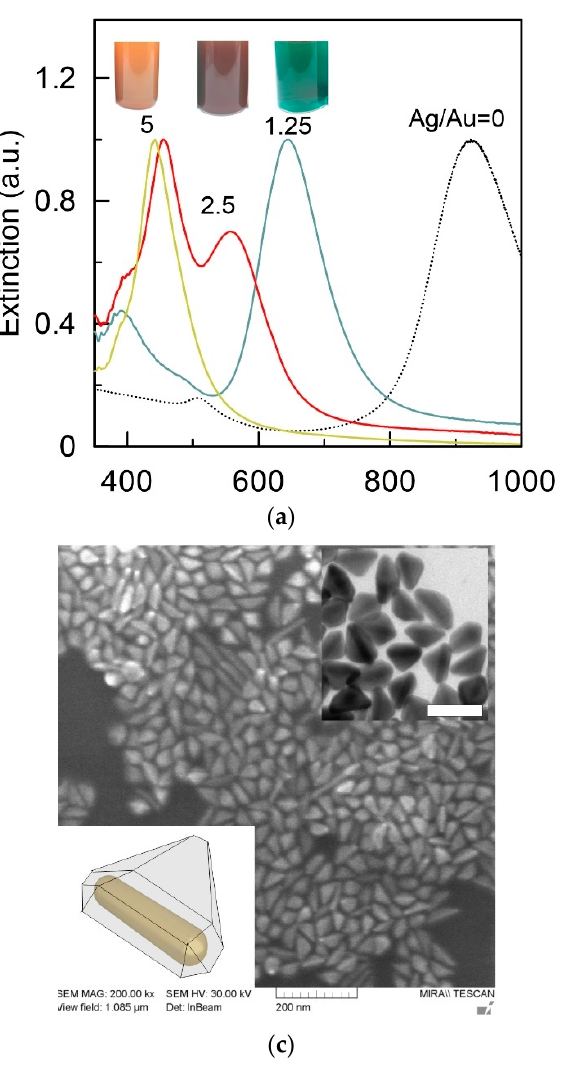
Figure 2. ( a ) Extinction spectra of Au@Ag core–shell nanorods with embedded NBT. The nanopar- ticles were obtained using Ag-to-Au molar ratios 5 (yellow curve), 2.5 (red curve), and 1.25 (green curve). The dashed curve corresponds to extinction spectra of the original AuNRs The insert show image of bottles with Au@Ag core–shell nanorods (b- в ) SEM image of Au@Ag core–shell nanorods obtained using Ag-to-Au molar ratios of 1.25 ( b ), 2.5 ( c ), and 5 ( d ). The insert on the top corre- sponds to the TEM image of the nanoparticles. The scale bar is 100 nm. The left-bottom inserts show the most probable structure of nanoparticles.